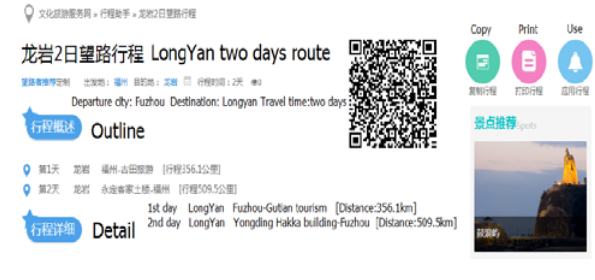
Figure 3. Route detail in Fujian